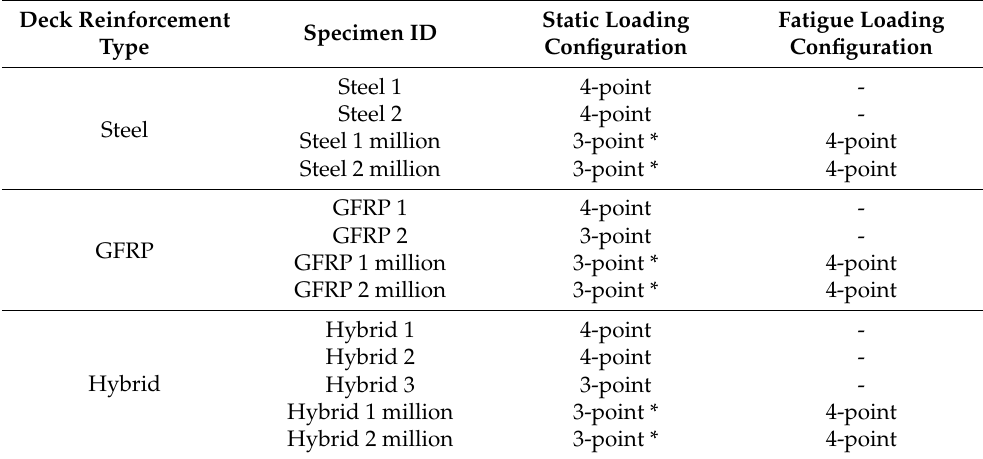
Static Loading Configuration